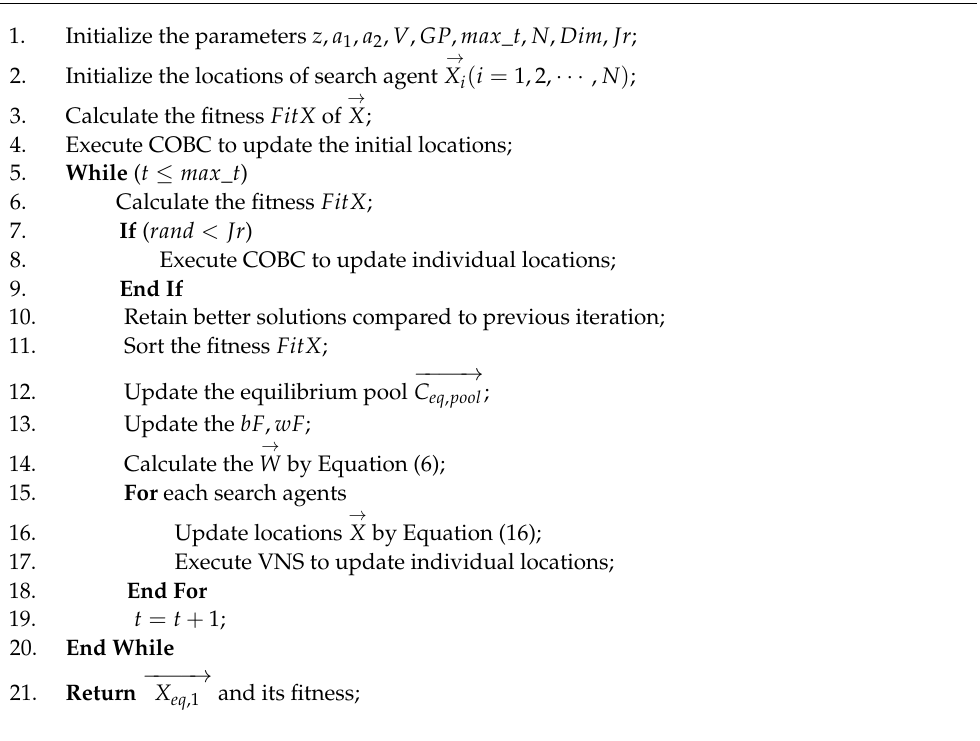
Algorithm 5: Pseudo-code of EOSMA for JSSP